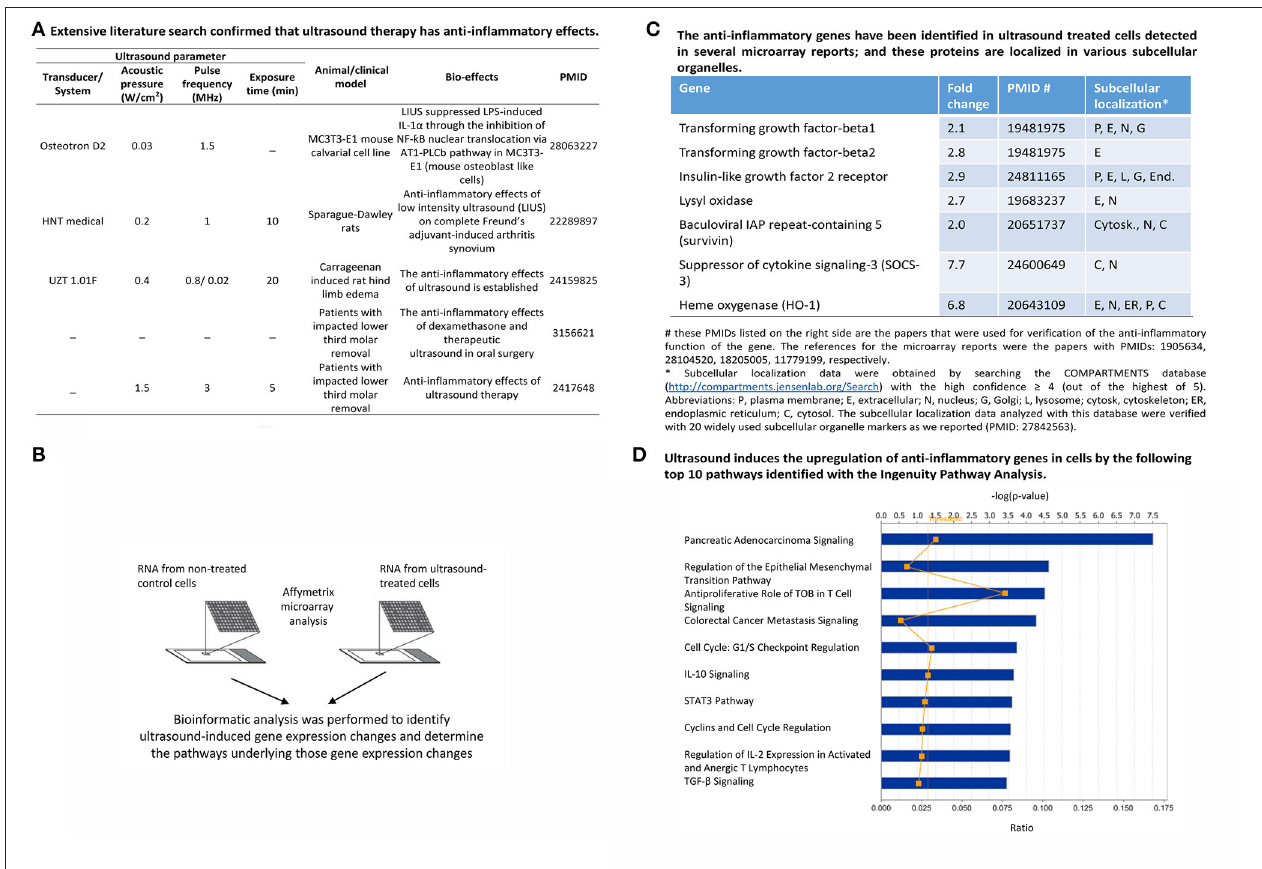
FIGURE 2 | LIUS exerts anti-inflammatory effects in various cell-, animal- and clinical models by upregulating anti-inflammatory gene expression. (A) An extensive literature survey confirmed that ultrasound therapy exerts anti-inflammatory effects. (B) Schematic representation of the logic behind the microarray analysis we conducted to determine the anti-inflammatory gene expression. (C) The list of anti-inflammatory genes that are upregulated with LIUS, revealed by our data analysis. (D) The major signaling pathways regulated by the anti-inflammatory genes that are upregulated by